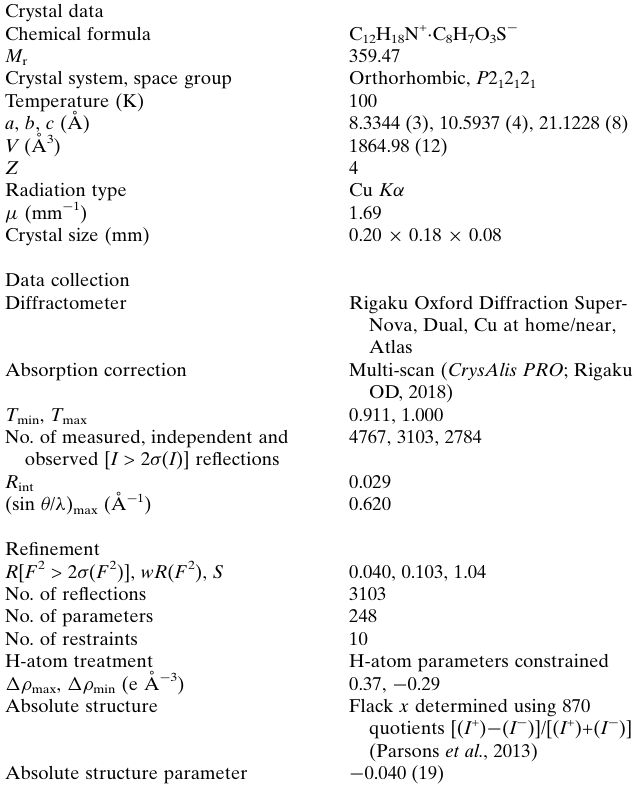
Table 3 Experimental details. Crystal data Chemical